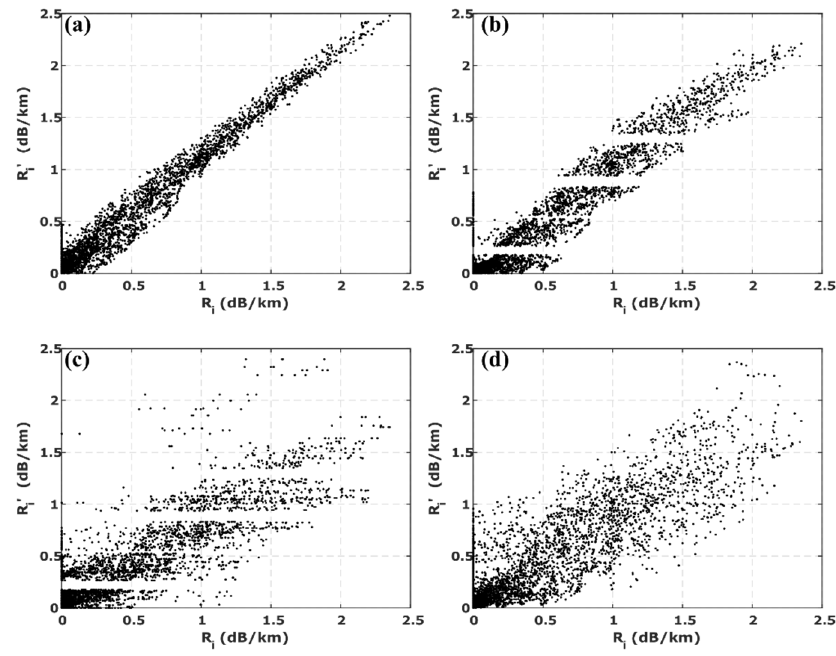
Figure 6. Scatter plots of the retrieved specific attenuations against the reference values at the comparison points for different retrieval methods. Panel ( a – d ) are for the results in Figure 3c–e and Figure 5a, respectively.